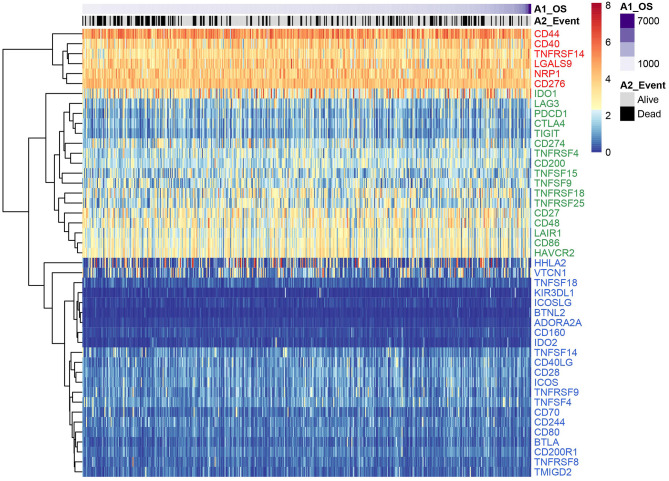
Unsupervised clustering of ICGs in the TCGA-LUAD cohort. The overall survival and status event were used as patient annotations. Red: high expression group; green: medium expression group; blue: low expression group.